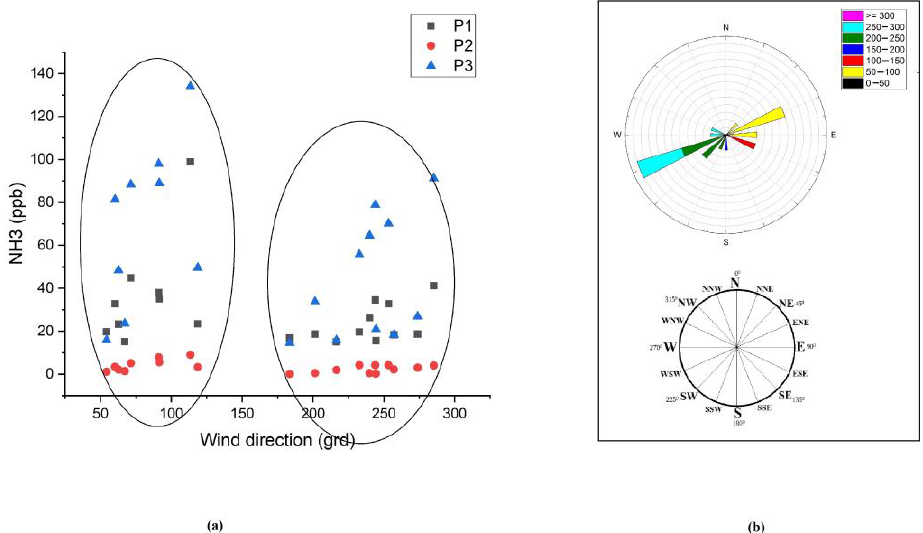
Figure 8. Dependence of ammonia on wind direction: ( a ) Ammonia concentration distribution in P1, P2, and P3 points as a function of wind direction; ( b ) The wind rose from March-August. The distribution of the daily averages of ammonia concentrations in the P1, P2, and P3 measuring points for the entire period according to wind speed can be seen in Figure 9. In this figure, it can be observed that part of the ammonia concentrations is distributed in the range of 2.5 – 4 m/s, but high values of ammonia concentration can be observed at the measuring point P3, where higher wind values are presented between 6 m/s and 7 m/s.